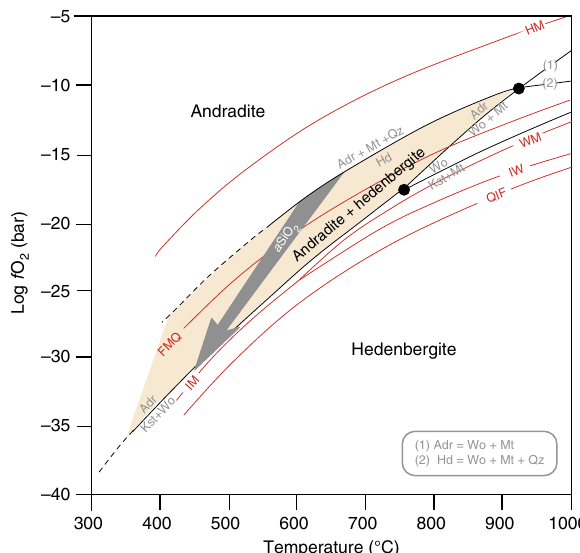
Fig. 2 Oxygen fugacity vs. temperature plot of the stability fi eld of hedenbergite and andradite. Both single phases: andradite and/or hedenbergite, are stable over a range of log f O 2 and T , and poorly constrained their conditions of formation 17 . Nevertheless, this thermodynamic framework is consistent with the present subdivision of CV3 chondrites into andradite-bearing oxidized (CV Ox ) and kirschsteinite- bearing reduced (CV Red ) subgroups and their inferred different conditions of formation. When the two phase assemblage andradite + hedenbergite is considered, the redox conditions of formation of the Ca-Fe-rich secondary phases could be a bit more restricted but the temperature remains still poorly constrained. Low silica activity of CV3 chondrites is an overlooked key parameter controlling the stability fi eld of the Ca-Fe-rich secondary phase assemblages: the gray arrow indicates the effect of decreasing the silica activity of the system on the stability fi eld of